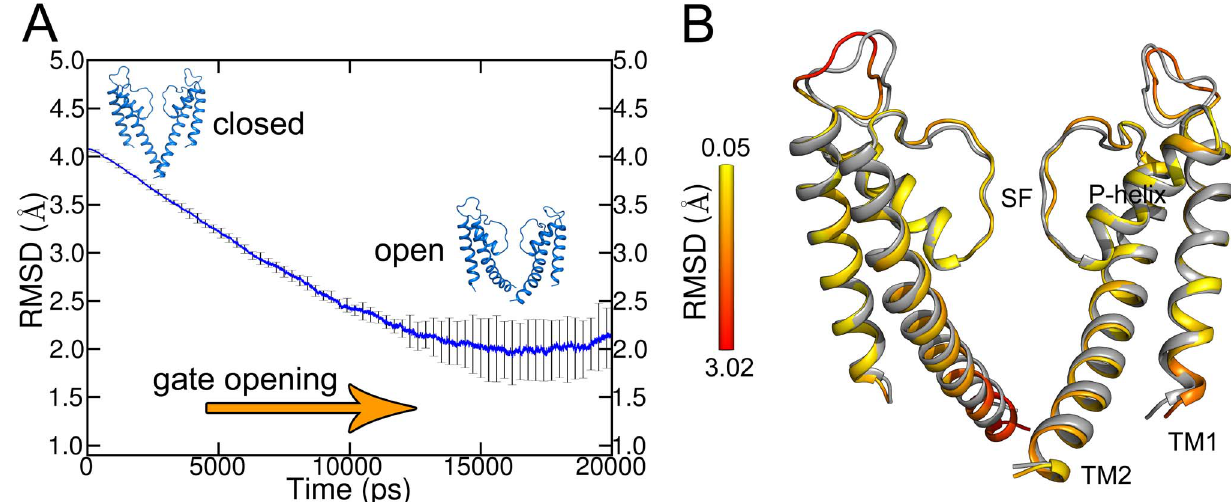
Figure 1. RMSD analysis of ED opening simulations. A) Average of the backbone RMSD (without loops) of ten opening ED simulations. The open crystal structure was used as reference. The standard deviation is indicated by error bars. B) Comparison of the average structure (built out of the minimal RMSD structures of the ten ED simulations; yellow to red) and the open crystal structure (gray). The RMSD of the C a atoms is shown as a spectrum from yellow to red. For the sake of clarity, only the two opposite SUs are shown.